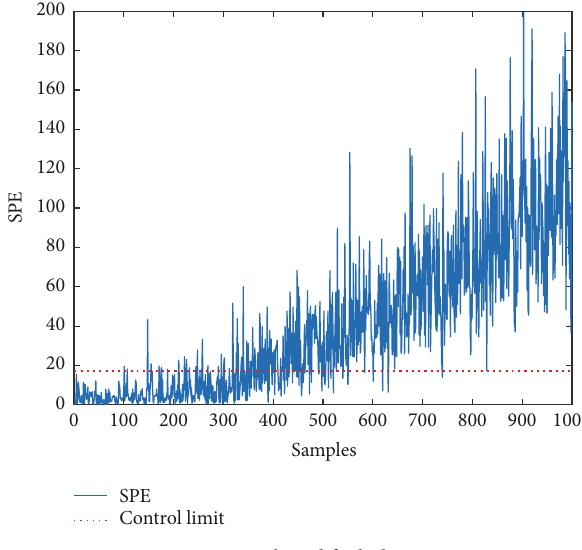
Figure 1: PCA based fault